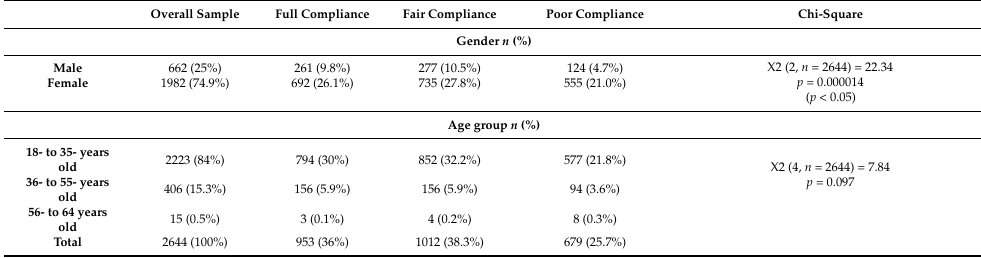
Table 2. Compliance in different age groups and by